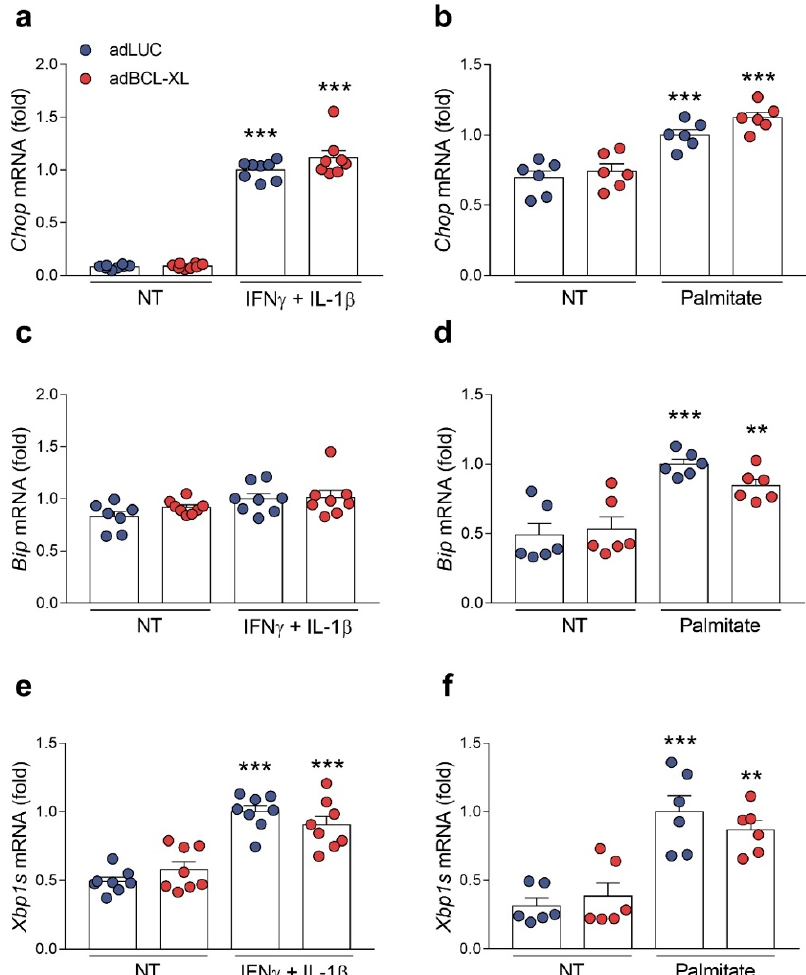
Figure 6. BCL-XL overexpression alleviates ER stress upon inflammatory or metabolic insults in rat β -cells. INS-1E cells were infected with adenoviral (ad) vectors encoding luciferase (adLUC, blue dots) or rat BCL-XL (adBCL-XL, red dots). After 48 h of recovery, cells were left untreated (NT) or treated with either IFN γ + IL-1 β (10 and 100 U/mL, respectively) ( a , c , e ) or 0.5 mM palmitate ( b , d , f ) for 24 h. The mRNA expressions of Chop ( a , b ), Bip ( c , d ), and Xbp1s ( e , f ) were analyzed by RT-qPCR and normalized by Gapdh . Results are the means ± SEM of the 6 to 8 independent experiments. ** p ≤ 0.01 and *** p ≤ 0.001 vs. untreated (NT) and infected with the same adenoviral